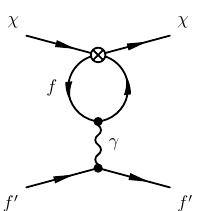
Figure 4: The mixing of dimension-six four-fermion operators into each other via the photon penguin